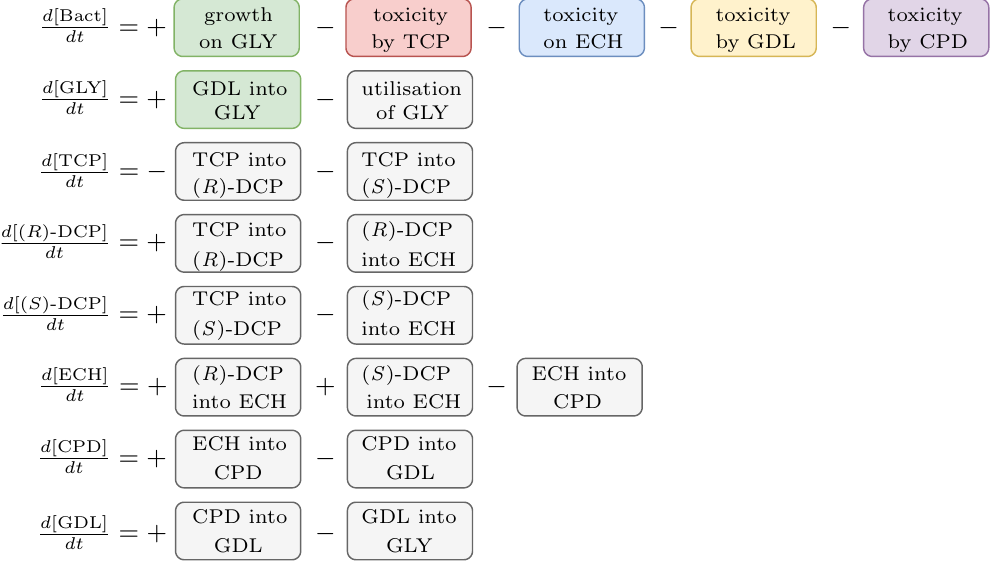
Figure 4. Proposed model scheme. A schematic description of the novel ODE model with highlighted extending partitions. Each partition (i.e., module) represents a linearly independent part of a particular equation. Each module has a unique semantic function. Note that some of the modules are used in more than one equation. The coloured modules represent entirely new parts of the final model and the grey modules were extended in this study. This modular feature was necessary to handle the fitting of such a complex model to the experimental